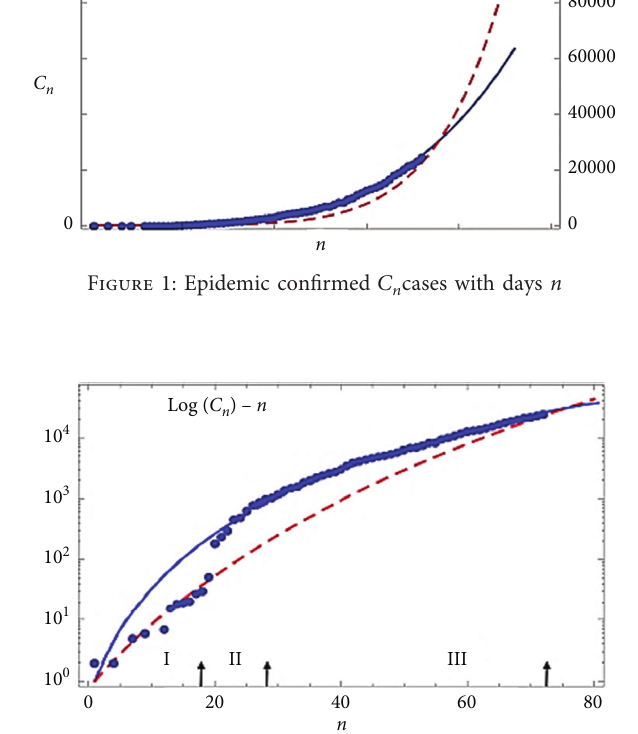
Figure 2: Confirmed epidemic log ( C ) cases with days n n Figure 3 exemplifies the growth of COVID-19 confirmed patients ( C n ) followed by the DG 2 M curve (in black-dashed line) for K � 100000, α � 2, p � 0 . 74, and r � 0 . 74 plotted against the number of days, n. The blue dots reflect the real time and the red line shows the DG 2 M results for p � 0 . 875 and r � 0 . 3.